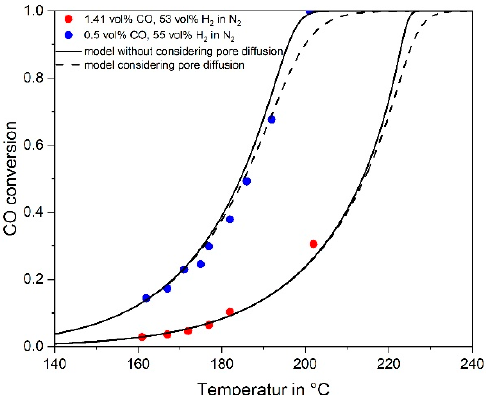
Figure 8. Measured and modelled conversion of CO for a feed gas with 1.41 or 0.5 vol% CO, 55% H 2 , rest N 2 ( τ (190 ◦ C) = 300 kg · s · m − 3 for 1.41% CO and 227 kg · s · m − 3 for 0.5% CO, p = 1 bar).